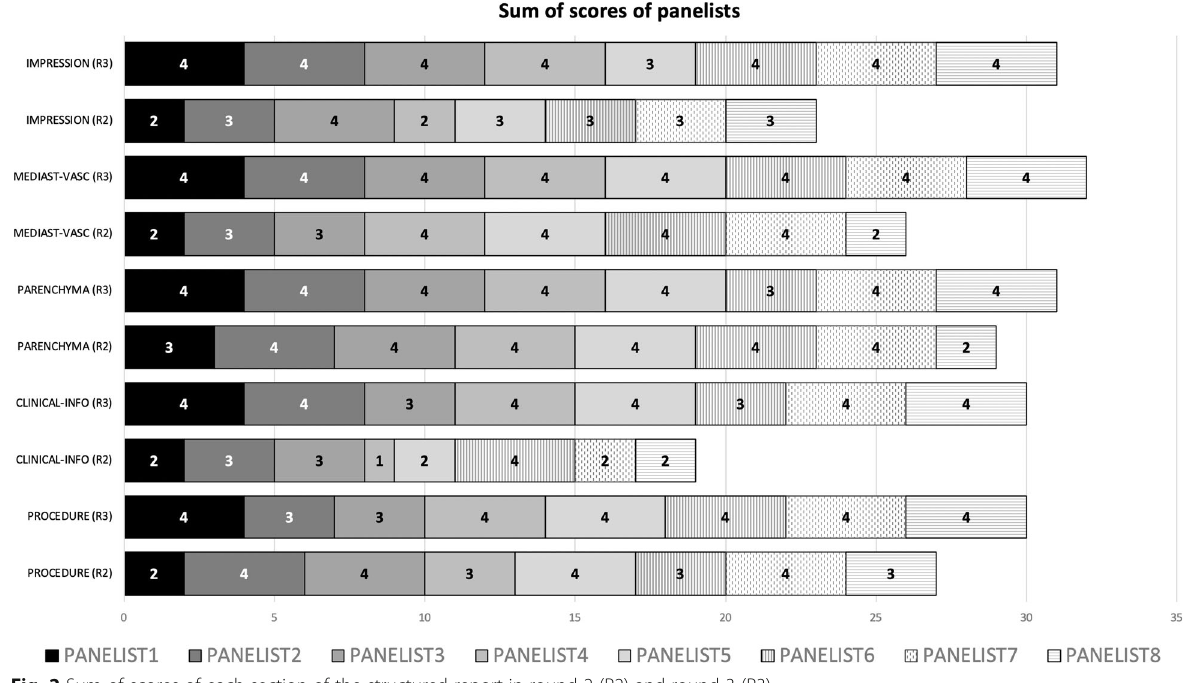
Fig. 2 Sum of scores of each section of the structured report in round 2 (R2) and round 3